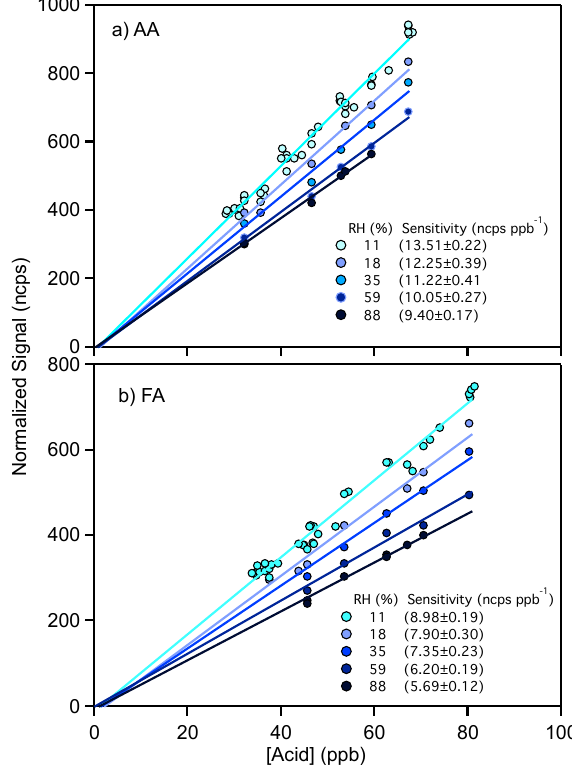
Figure 3. (a) AA and (b) FA calibration curves for varying humidity levels at E/N = 125Td. Each line represents a linear least squares fit to the data at a given humidity. The normalized sensitivity is ob- tained as the slope in each case, and the corresponding relative hu- midity values are listed. Quoted uncertainties are ± 2 σ